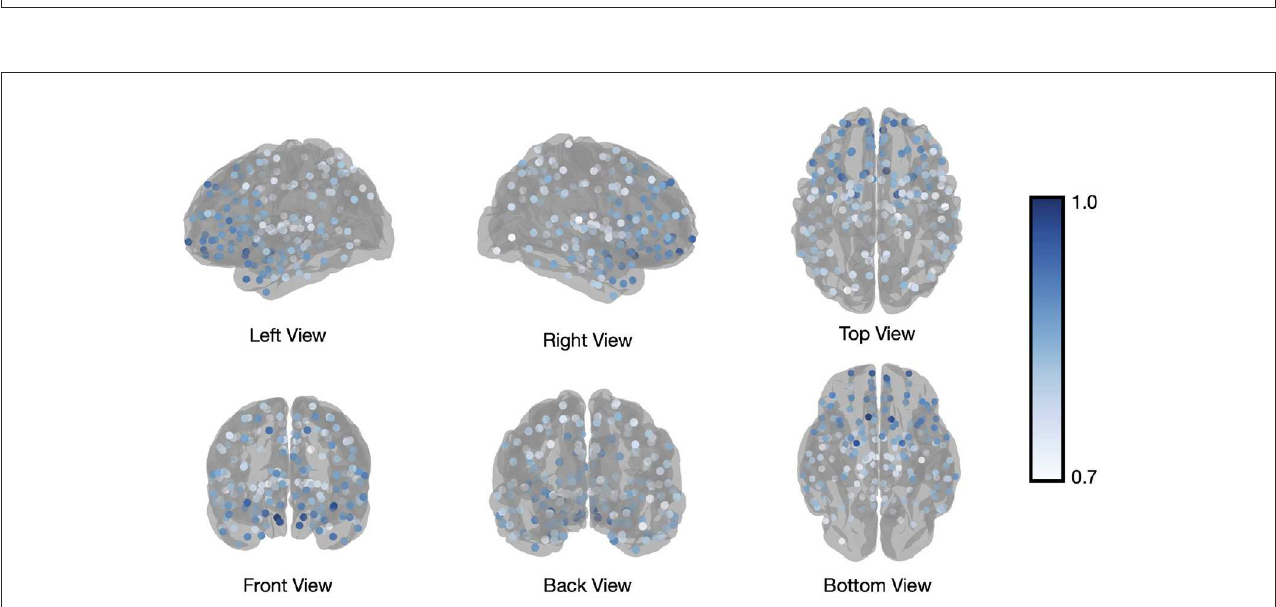
FIGURE4 Brainnetome atlas brain regions switching. Number of affiliation switches between consecutive windows for regions of the Brainnetome Atlas, averaged across all subjects and normalized to the most frequently switching node to yield values between 0 and 1. The visualized regions are those with values higher than